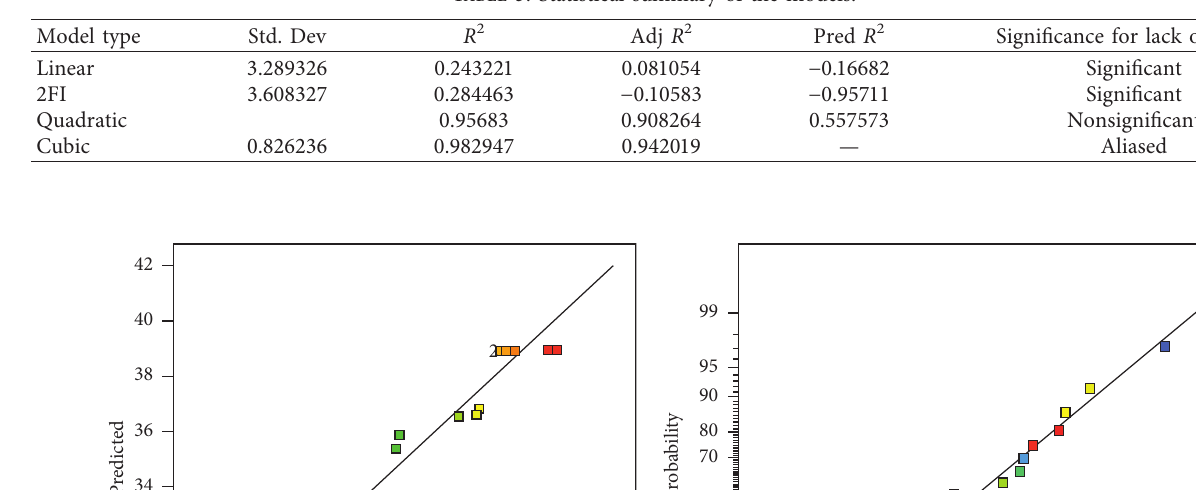
Table 3: Statistical summary of the models.